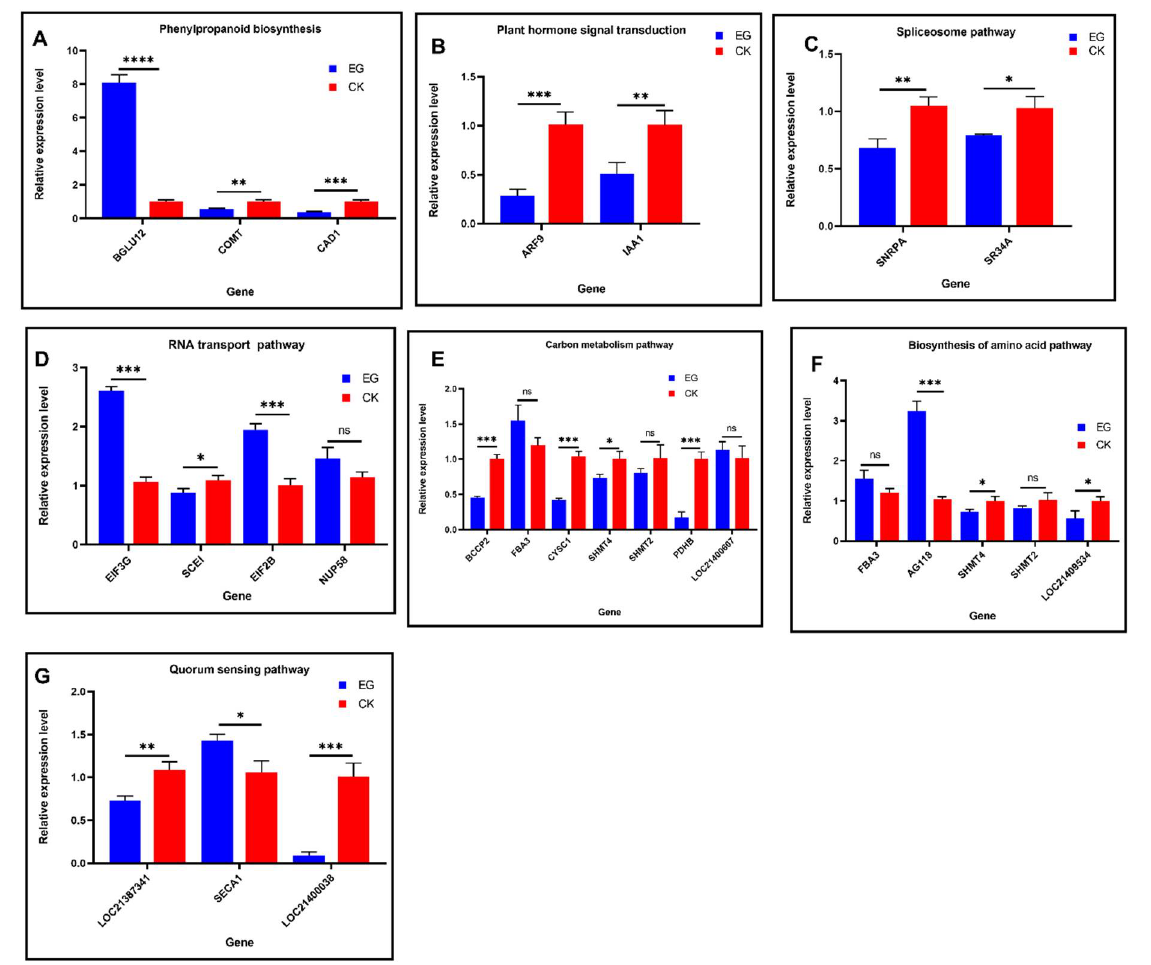
Figure 12. qRT-PCR results of DMGs and DEGs in the KEGG enrichment pathways. From ( A – G ), represent the various KEGG pathways. Mulberry actin3 gene was used as the internal control gene. The mean value ± SD was used to analyze the relative transcript level of each gene by the 2 −ΔΔCt method. The qRT-PCR reactions were run with three biological replicates in three technical replicates. Statistical analysis was performed using unpaired Student’s t-test by GraphPad Prism9 version 9.0.0 for Windows, GraphPad Software, San Diego, CA, USA. A p < 0.05 was considered significant. * p < 0.05, ** p < 0.01, *** p < 0.002, **** p < 0.0002, ns = not